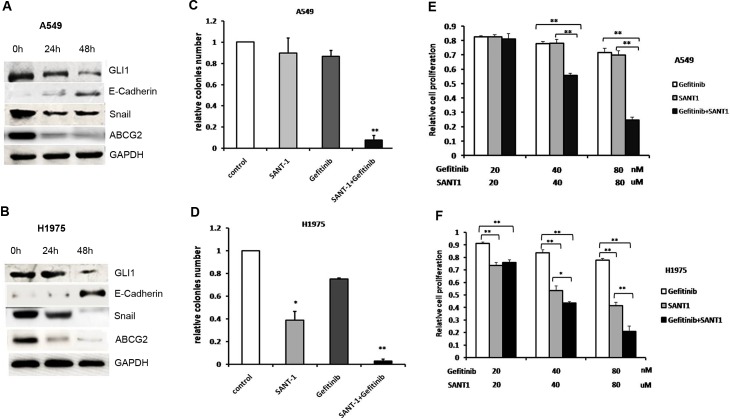
Hh inhibition reversed EMT and decreased the ABCG2 expression in EGFR-TKI-resistant NSCLC cells and the combination of gefitinib and SANT1 synergistically inhibited tumorigenesis and proliferation in EGFR-TKI-resistant NSCLC cell lines.(A) and (B), Western blot analysis of the Hh signaling pathway activity and its target genes E-Cadherin, Snail and ABCG2 in EGFR-resistant cells A549 and H1975 after SANT-1 treatment for 0, 24, and 48 h. (C) and (D), colony formation quantitative analysis in A549 and H1975 cells; gefitinib alone or SANT1 alone did not inhibit clonogenic growth effectively. However, colonies very barely formed in the group subjected to combined SANT-1 and gefitinib treatment in A549 and H1975 cells; * (P<0.05), ** (P<0.01). (E) and (F), Proliferation of A549 and H1975 cells was assessed by MTT assay after treatment with the indicated concentrations of gefitinib alone, SANT-1 alone, or the combination of gefitinib and SANT-1; * (P<0.05), **(P<0.01).